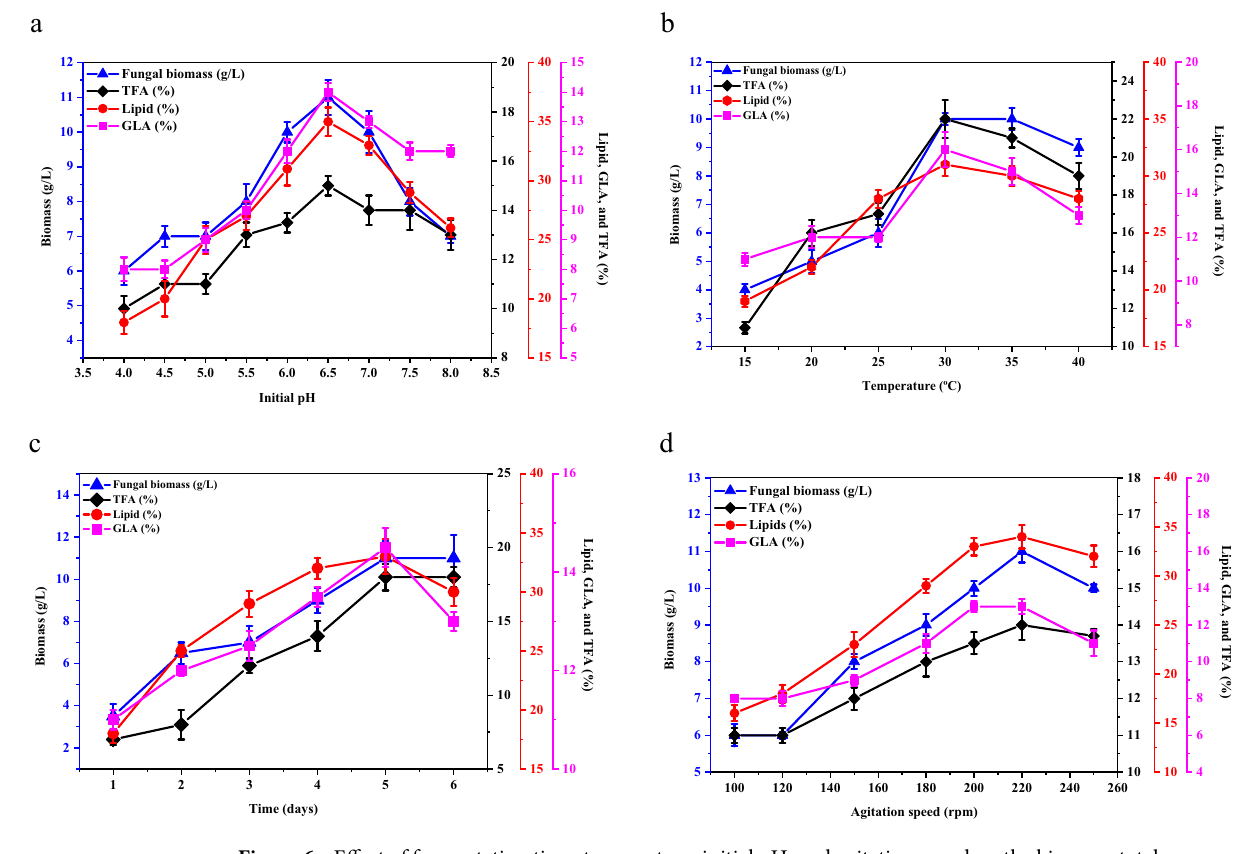
Figure 6. Effect of fermentation time, temperature, initial pH, and agitation speed on the biomass, total lipid, GLA, and TFA yields in M. plumbeus and B. subtilis cocultures. Error bars represent the SD across three biological replicates.